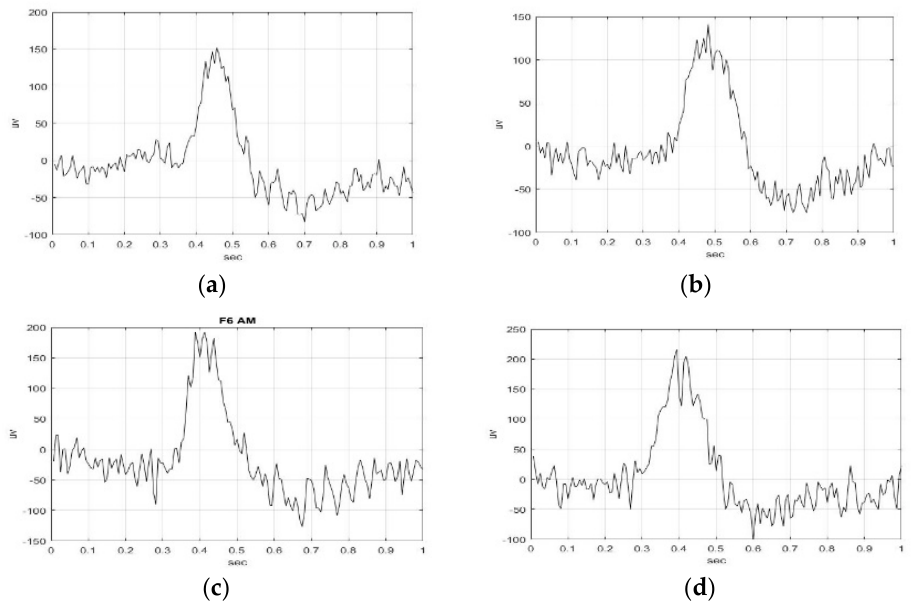
Figure 2. Sample 1(s) of F5AM, F5MI, F6AM, and F6MI EEG signal with time duration of 1 s. ( a ) F5AM, ( b ) F5MI, ( c ) F6AM, and ( d ) F6MI.